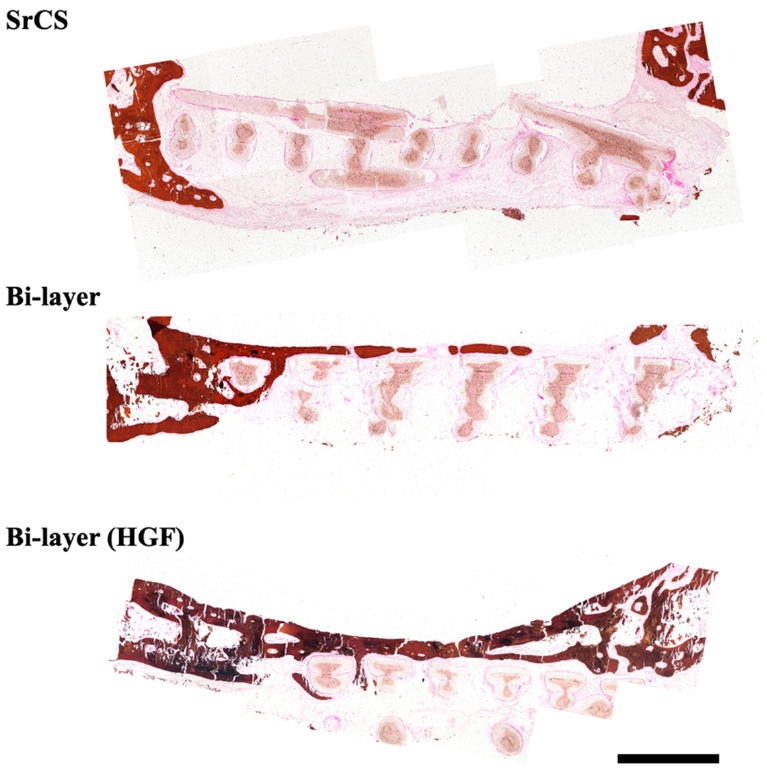
Figure 10. Histological analysis of new bone regeneration around and within the scaffolds in the osteoporotic rabbits’ cranial bone defect model. The Von Kossa (VK) stain of regenerated bone mass after 12 weeks of regeneration in the in vivo experiment. The scale bar is 1 mm.